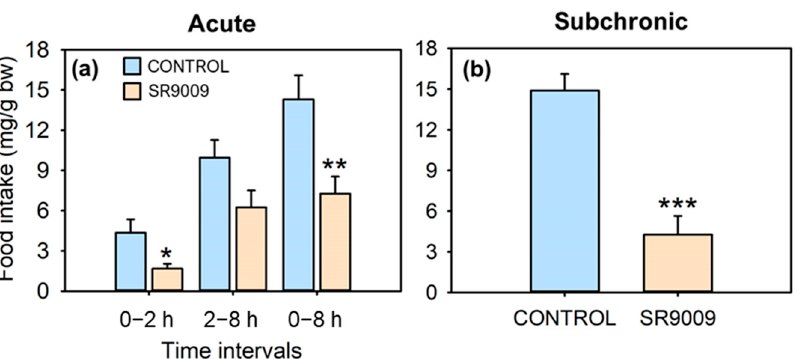
Figure 1. Effect of acute and subchronic SR9009 treatment on food intake in goldfish ( Carassius auratus ). ( a ) Food intake in the intervals of 0 − 2, 2–8, and 0–8 h after acute IP injection of vehicle alone (CONTROL) or containing SR9009 (100 µg/g bw, n = 9 fish/group). ( b ) Average daily food intake in the lapse of 2 h during subchronic (7 days) vehicle or SR9009 (100 µg/g bw) IP administration ( n = 12 fish/group). Data are expressed as mean + S.E.M. * p < 0.05, ** p < 0.01, *** p < 0.001 SR9009 compared to control group (Student’s t -test).